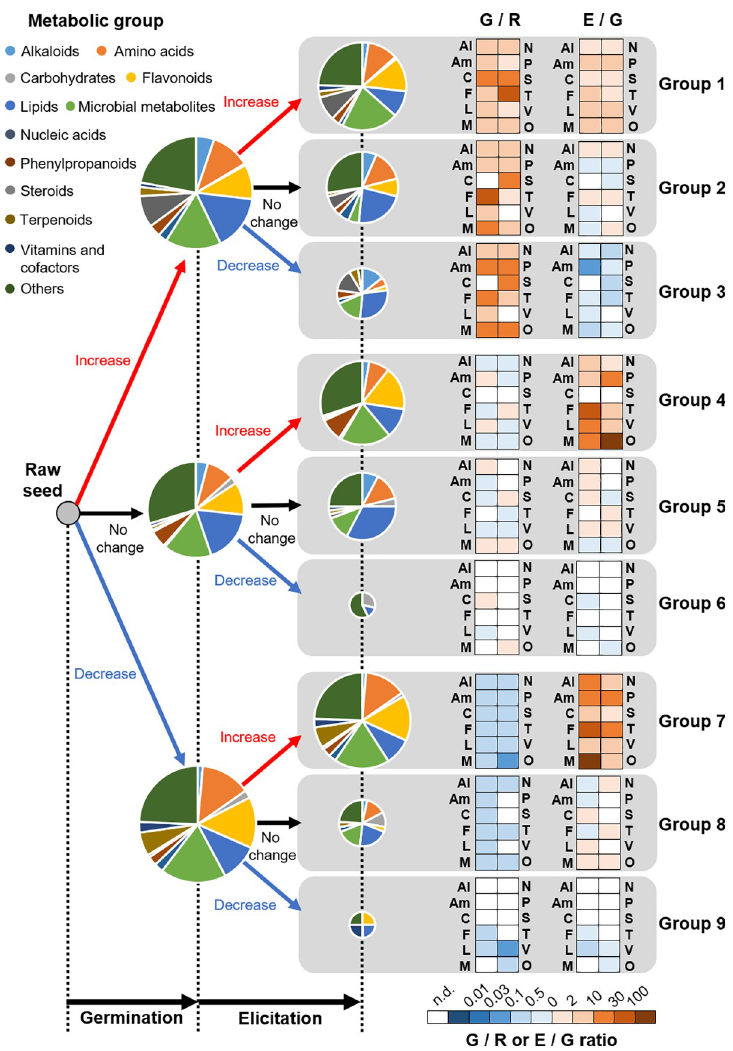
Fig 3. Estimated effects of germination and elicitation on the metabolic profile of raw seed, germination, and elicitation samples. The pie chart and heat map represent the proportion and average change ratios of individual metabolic groups, respectively. The size of the pie chart represents the number of estimated metabolites (appended under arrows). Metabolic groups: Al, alkaloid; Am, amino acid; C, carbohydrate; F, flavonoid; L, lipid; M, microbial metabolite; N, nucleic acid; P, phenylpropanoid; S, steroid group; T, terpenoid group; V, vitamin and cofactor group; O, other. Details of the metabolites are given in S1